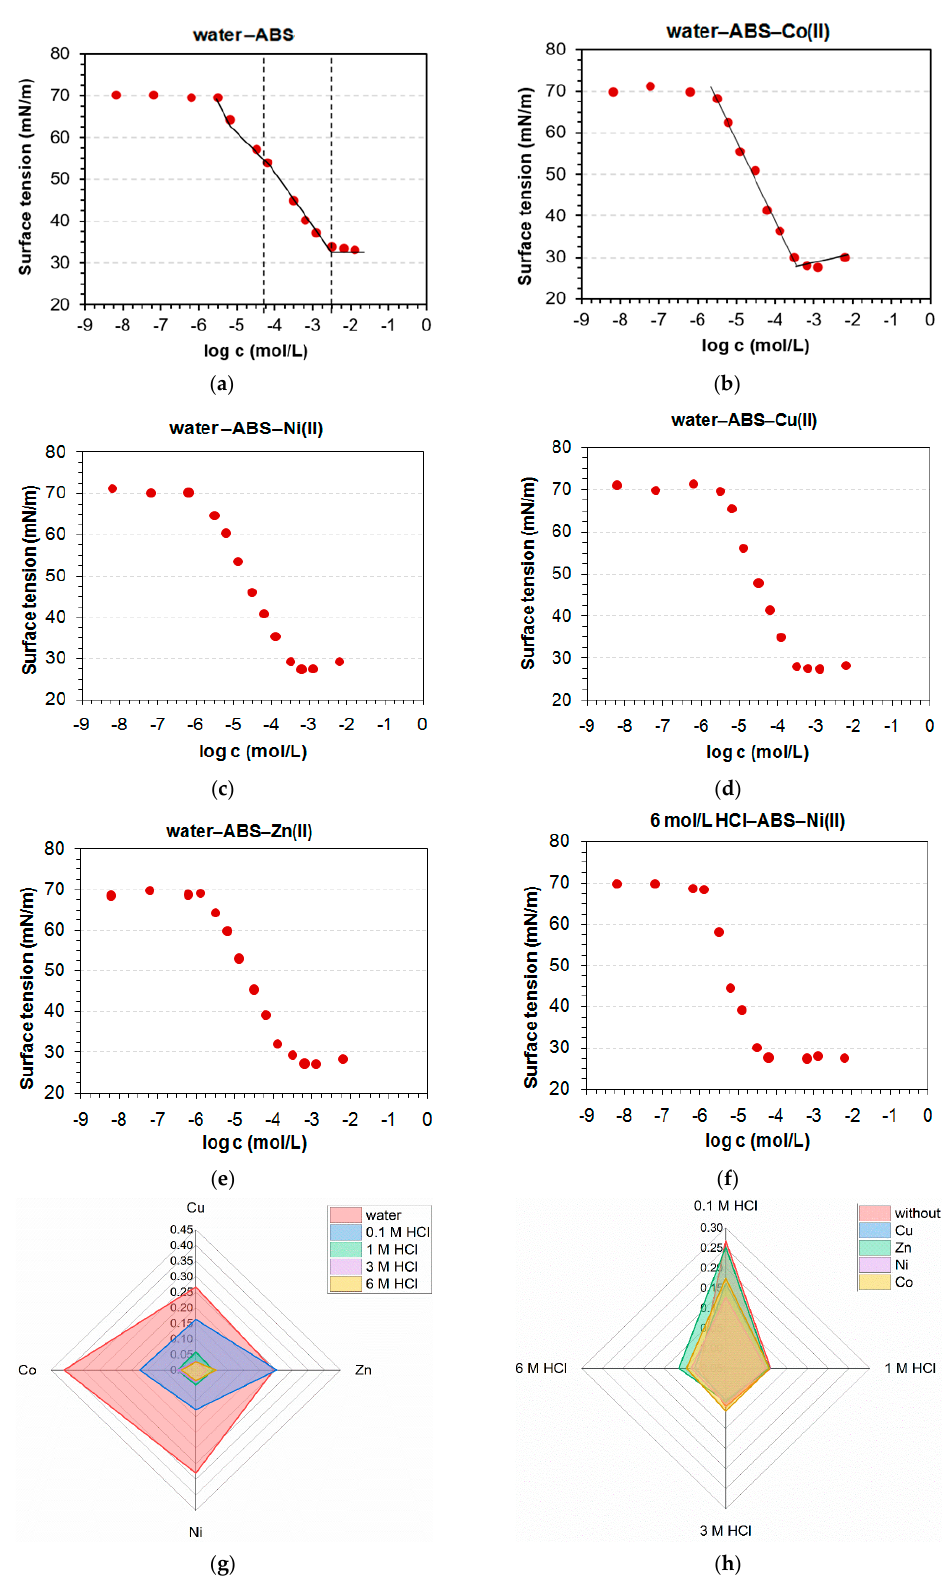
Figure 1. The adsorption isotherms for the ABS surfactant without ( a ) and with ( b – f ) heavy metals in water ( a – e ) and HCl ( f ) systems with constant concentration of heavy metal ions equal to 100 mg/L and effect of HCl concentration ( g ) as well as type of heavy metal ions ( h ) on CMC values.